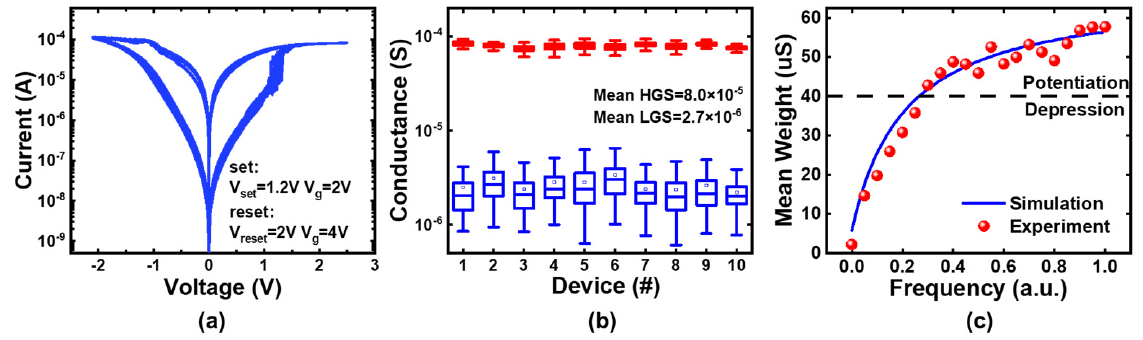
Figure 3. Basic properties and SRDP characteristics of the memristor. ( a ) The I-V characteristics; ( b ) The conductance distribution of ten devices; ( c ) Measured and simulated SRDP characteristic.